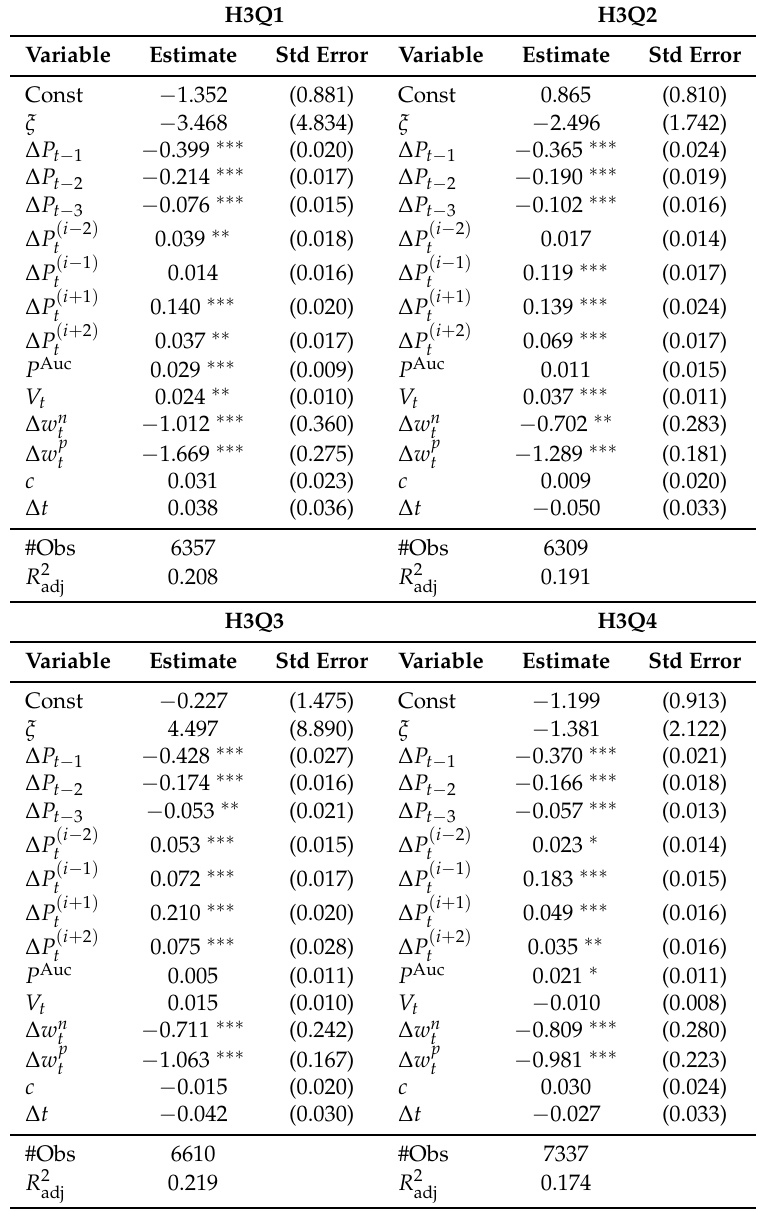
Table 3. Estimation results of the econometric model (1) for intraday price changes ∆ P t of 15-min. contracts